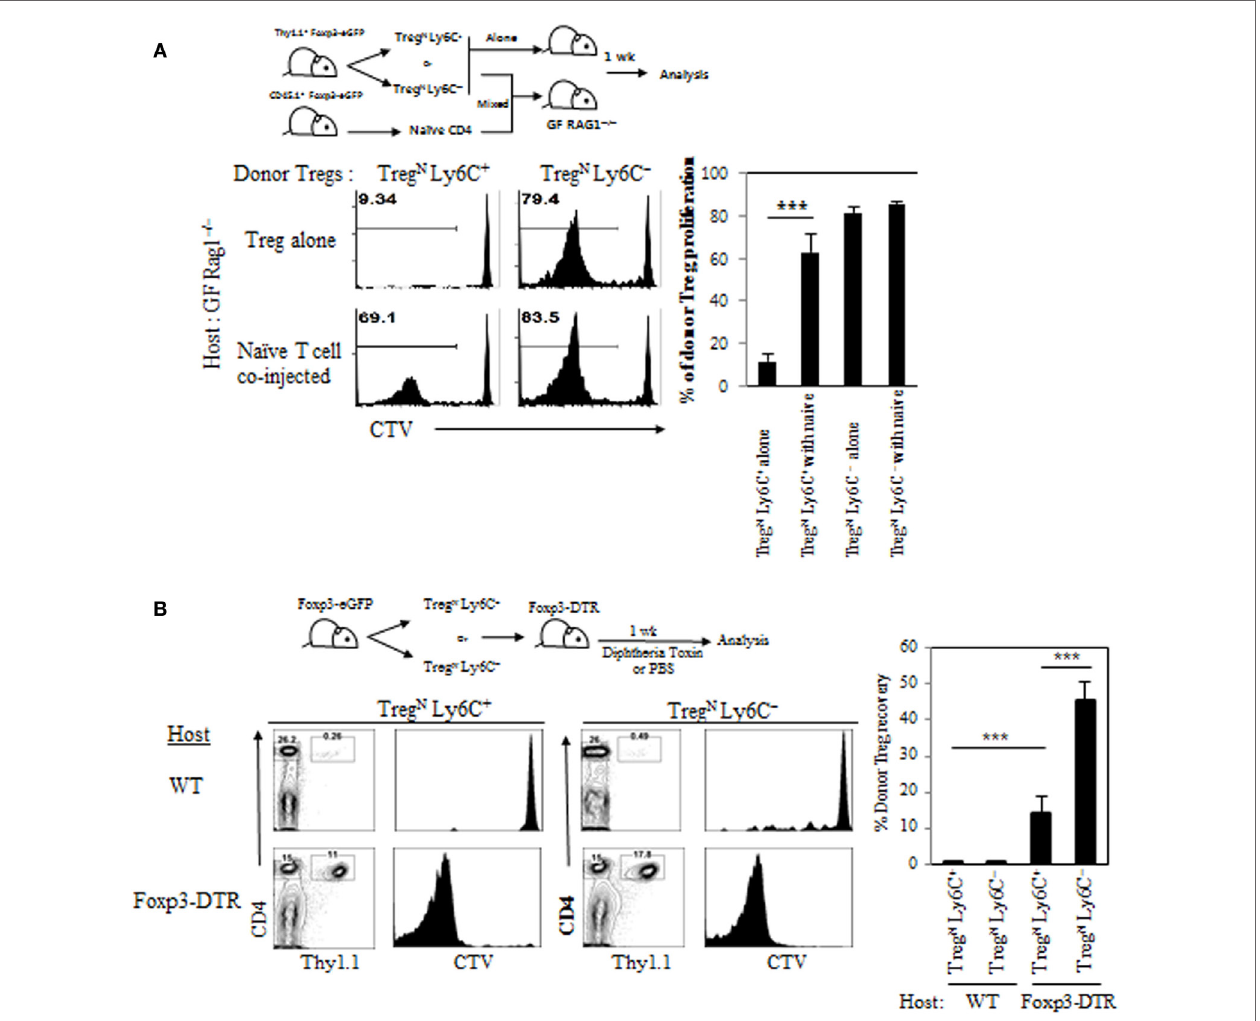
FigUre 6 | Role of Tconv Eff cells in functional restoration of Treg N Ly6C + cells. (a) T regulatory (Treg) subsets from Thy1.1 + Foxp3-eGFP mice were labeled with cell tracker violet (CTV) and then injected into germ-free Rag1 − / − hosts in the presence or absence of naive CD4 T cells. Shown are proliferations of donor Treg subsets on day 7. (B) Treg subsets from Thy1.1 + Foxp3-eGFP mice were labeled with CTV and then injected into wild type or Foxp3-DTR hosts. The hosts were treated with 1 µg of diphtheria toxin in every other day. Donor cell proliferation was analyzed on day 7 after transfer. The data are representative of three to four experiments comprising three to four mice per group. * p < 0.05, ** p < 0.01, and *** p <